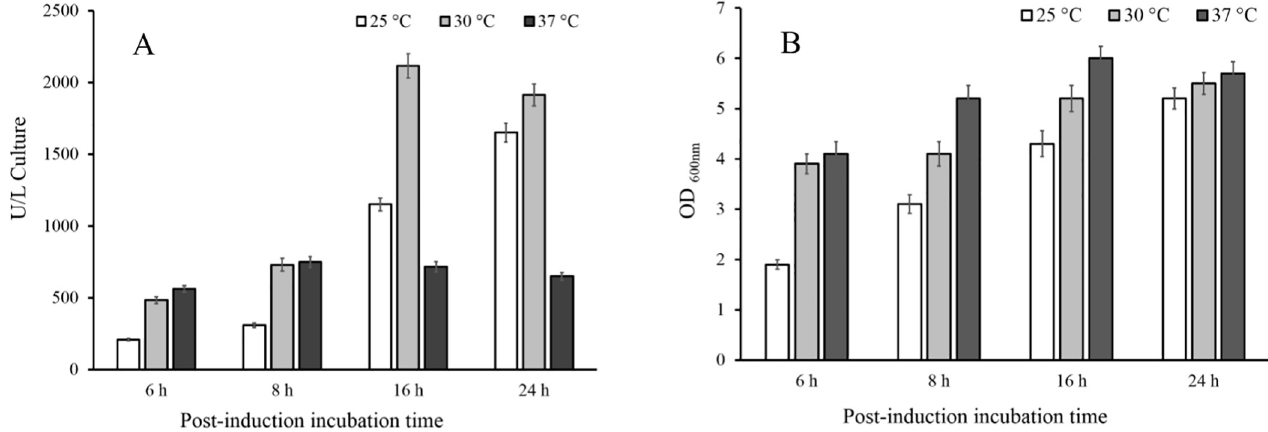
Fig 5. Comparison of cholesterol oxidase production and cell growth at various post-induction incubation times and temperatures. ( A) Total enzyme activity was measured after various temperatures during the indicated period of time; ( B) Final biomass production determined after different post-incubation temperatures and times.